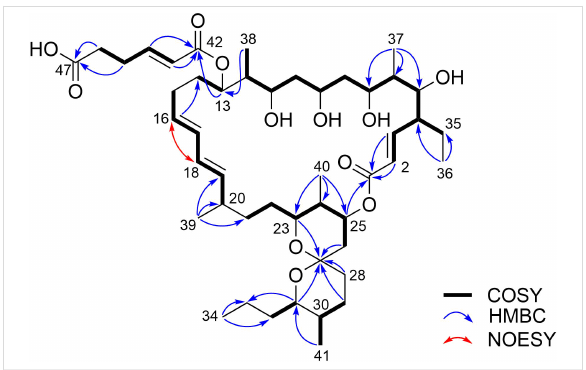
Figure 6: COSY, key HMBC and NOESY correlations of compound 2